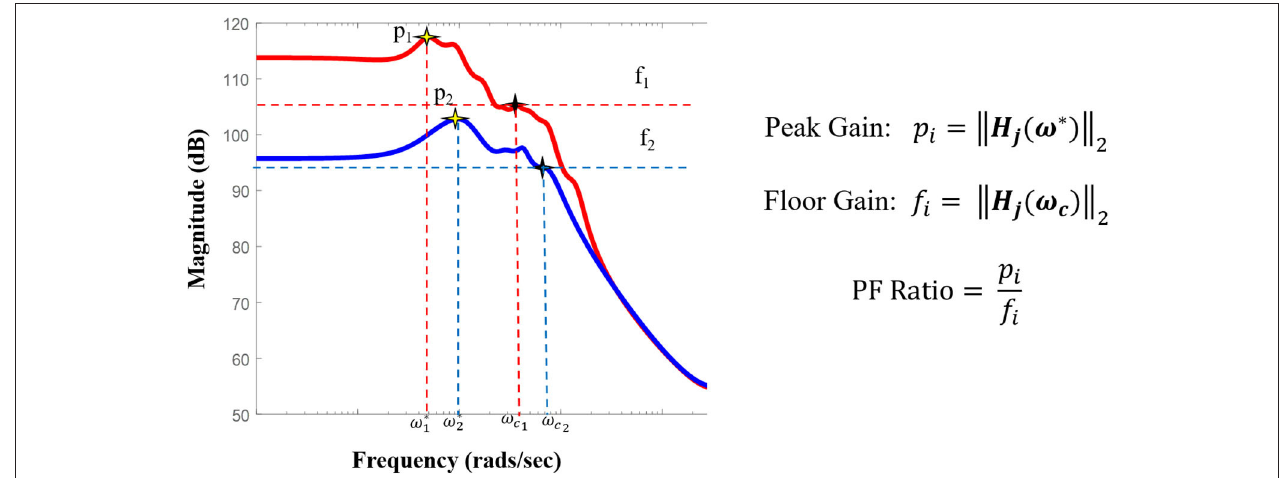
FIGURE 4 | Pictorial representation of the PF ratio and its calculation. Representative bode plot of two transfer function models, where red denotes a clinically annotated SOZ dataset and blue denotes a dataset stimulated that is not part of the epileptogenic region, with their labeled peak and cutoff frequencies, ω * and ω c, respectively. The cutoff frequency is defined as the frequency for which the magnitude is 3dB less than the gain at frequency 0, ω = 0 (DC